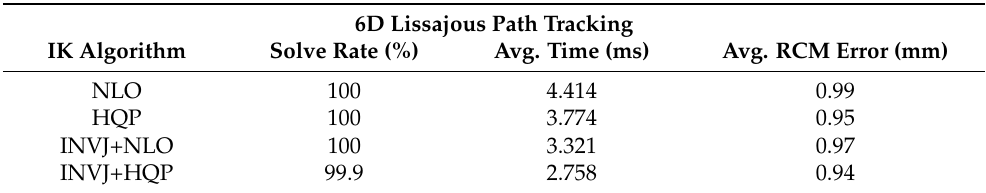
Figure 14. ( A ) Average IK solving time for the surgical tool pose control task. ( B ) RCM error for each IK solver obtained from motion capture for each step of the Lissajous trajectory. Table 9. Solve rate and solving time performance for a 7-DOF robotic manipulator + 3 DOF RST tracking a 6D Lissajous